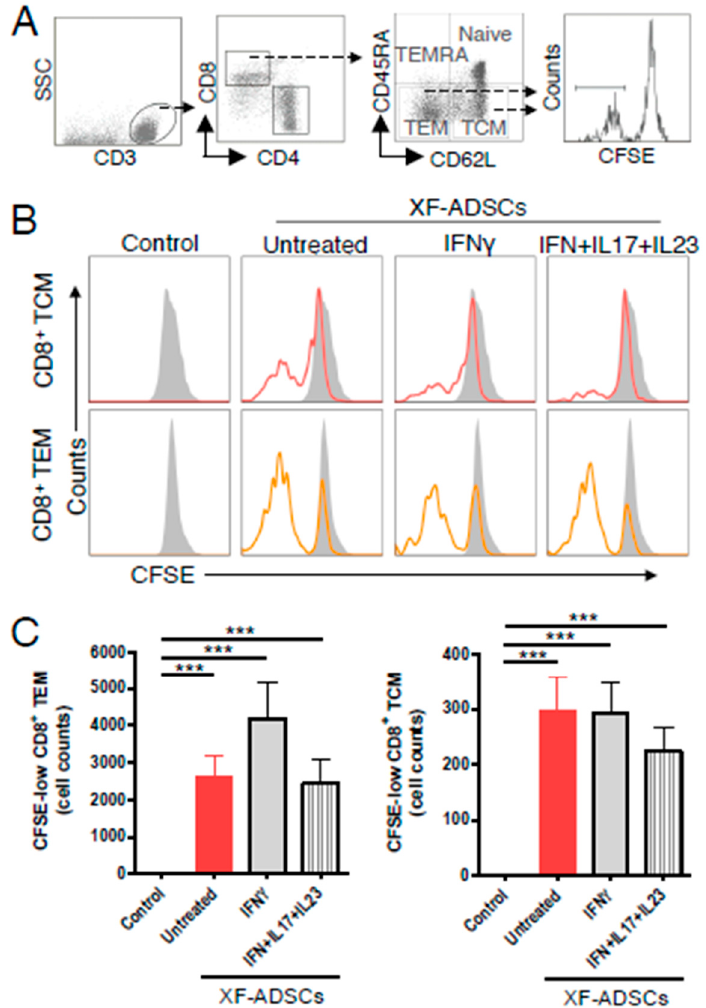
Figure 5. Production of alloreactive memory-CD8 T cells during allogeneic–antigen stimulation. XF-ADSCs were cultured with CD3 T cells and Td-PBMCs via the direct pathway, after 3 weeks whole cells were harvested and CD8 T cells were analyzed by flow cytometry. ( A ) Scheme for the flow cytometry analysis. ( B ) The histogram showed the CFSE-low memory-CD8 T cells in the population of memory-CD8 T cells on the 21st day after allogeneic–antigen stimulation, compared with the control. ( C ) Graphical representation of the number of CFSE-low memory-CD8 T cells corresponding to (B) ( n = 15 (each control and untreated), n = 13 (each IFN γ and IFN + IL17 + IL23)). The control does not contain XF-ADSCs and consist only of CD3 T cells and Td-PBMCs from healthy donor. The data were repeated at least three times; ***, p < 0.001.